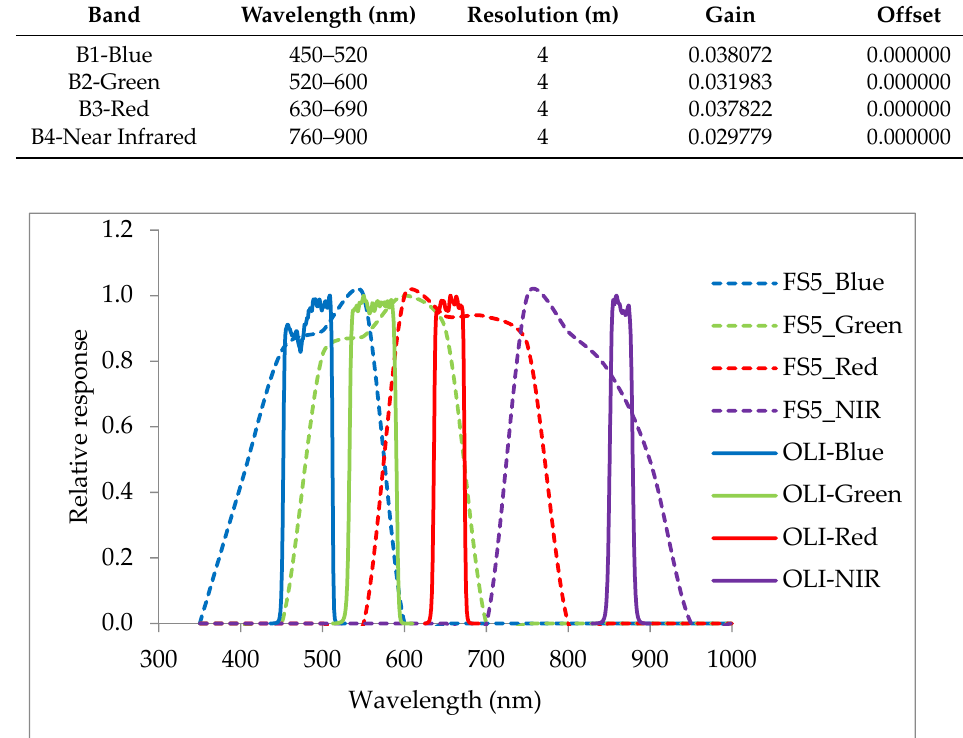
Figure 2. The spectral response function between FS5 and OLI overlaying the visible and near-infrared band.